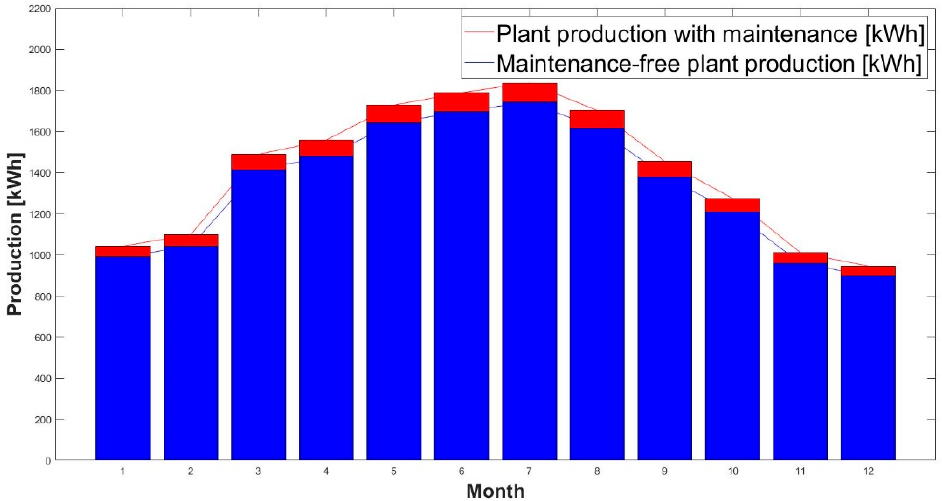
Figure 14. Variation in production at the Solar Energy Research Center (CIESOL) plant (9 kWp).